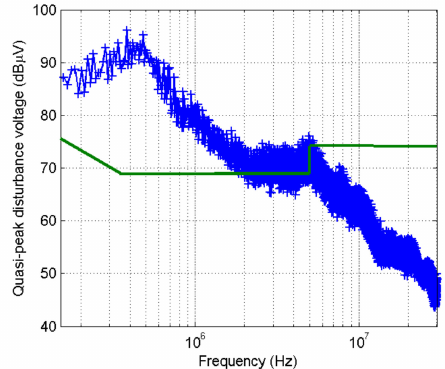
Figure 5. Testing for the conducted EMI. Measurement results for the no-load motor condition, no PWM, at the rotational speed of n = 5000 rpm. Speed is controlled by adjustment of the RMS value of the AC voltage feeding the drive. No input EMC filter. Green line denotes the standard imposed levels. The considered system exceeds them significantly up to 1 MHz.